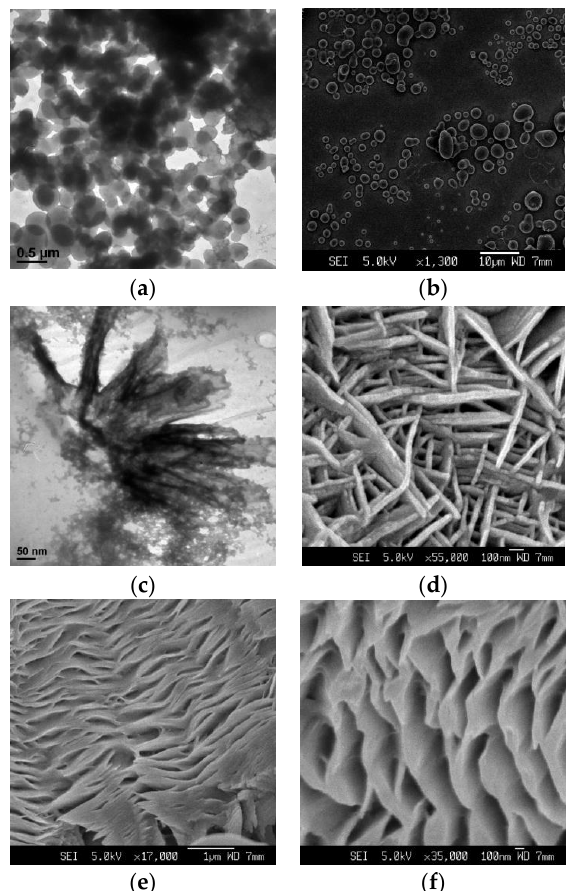
Figure 4. Concentration-dependent morphological control by the inclusion PT1 ⊃ G1 . ( a ) TEM